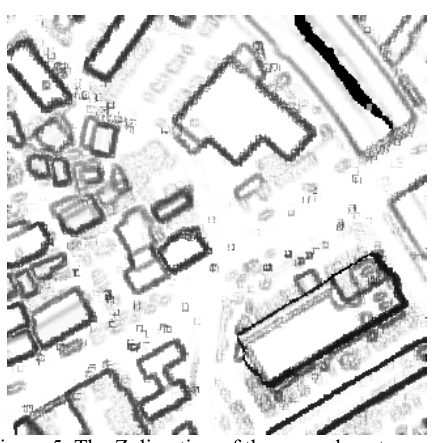
Figure 5. The Z direction of the normal vector